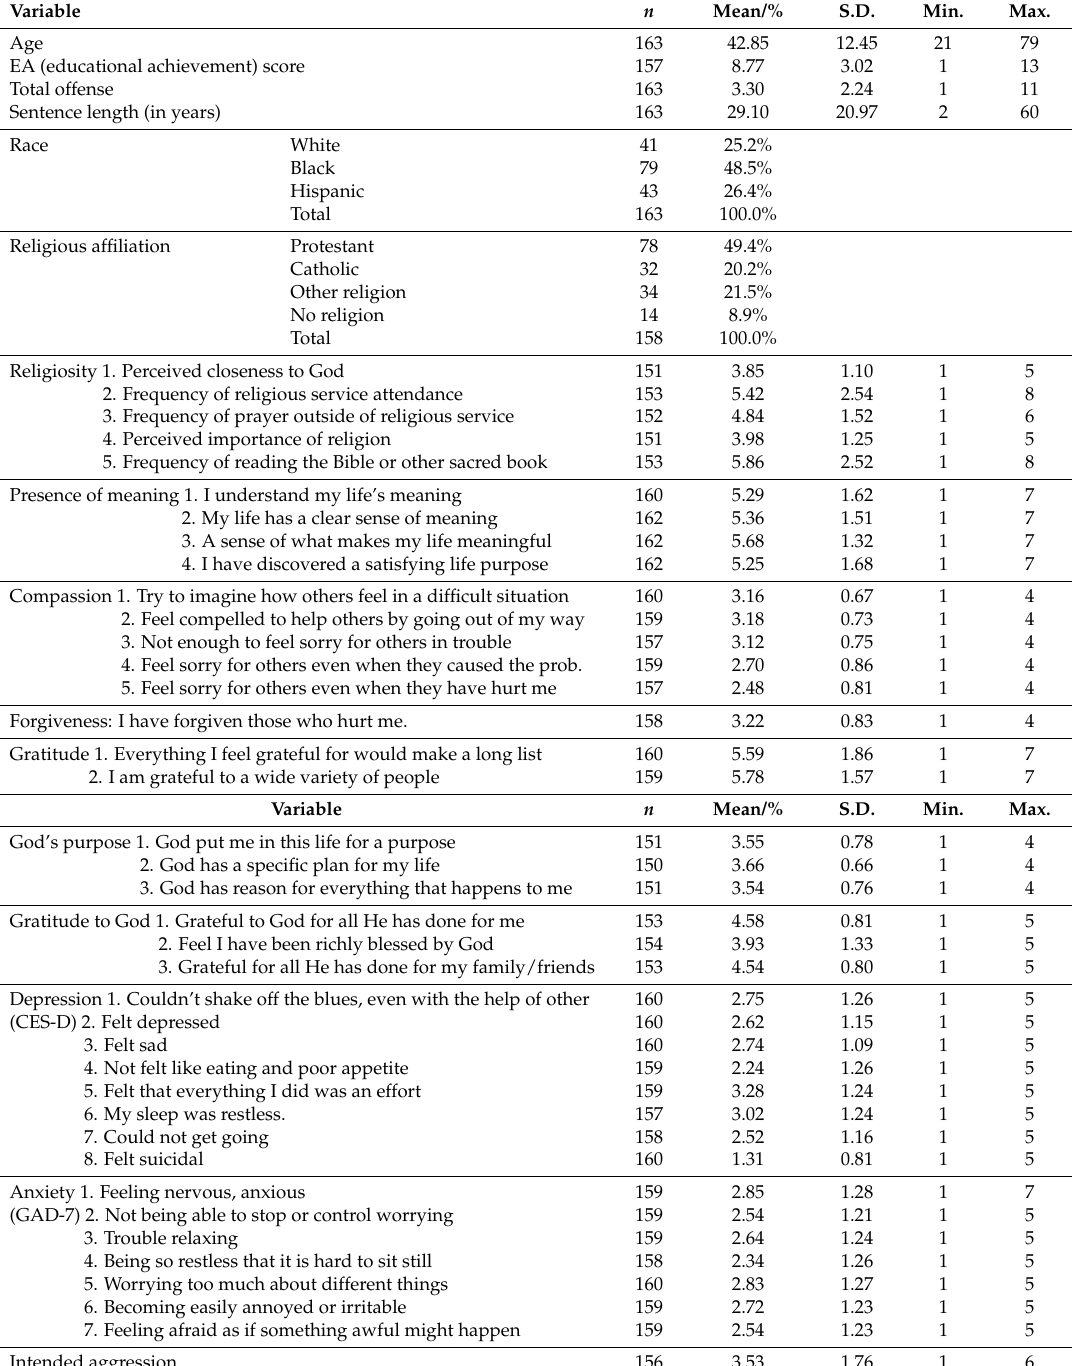
Table 1. Descriptive Statistics of Variables Included in Analysis ( n = 163). CES-D—Center for Epidemiologic Studies Depression; GAD-7—General Anxiety Disorder. Variable n Mean/% S.D. Min.